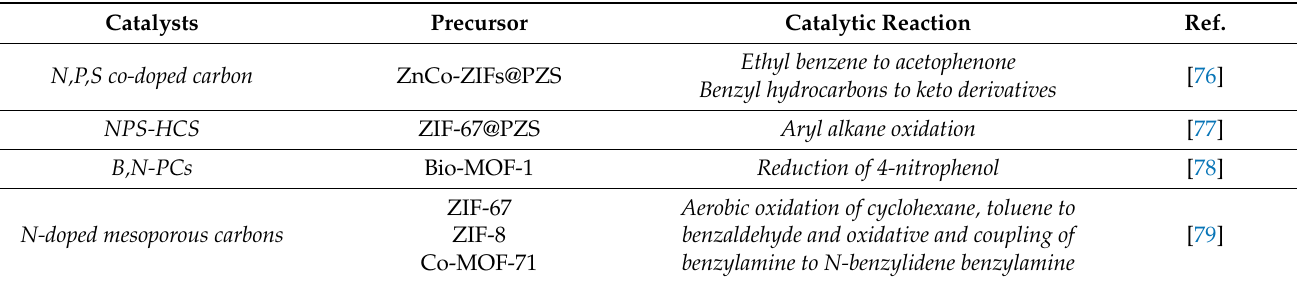
Table 1. Metal-free MOF-derived porous carbon catalysts applied in fine chemical syntheses.